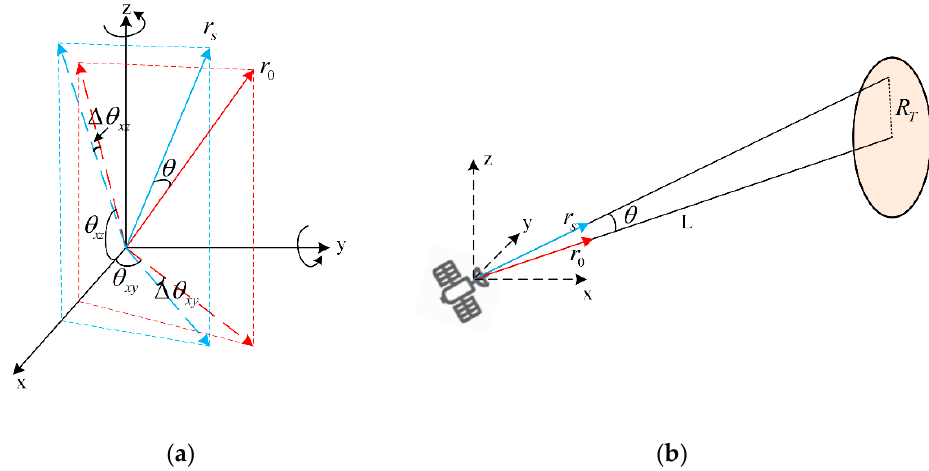
Figure 6. Schematic diagram of the transmitting signal of the terahertz wave transmitter: ( a ) the change of the signal beam emission angle in the antenna coordinate system; ( b ) the change of the signal beam emission direction.